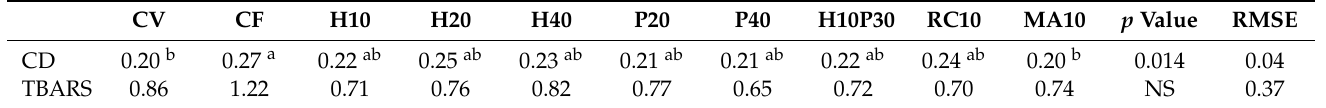
Table 6. Conjugated dienes (CD, mmol kg − 1 fresh tissue) and thiobarbituric acid reactive substances (TBARS, mg MDA-eq. kg − 1 fresh tissue) of the fillets from gilthead sea bream ( Sparus aurata ) fed the experimental